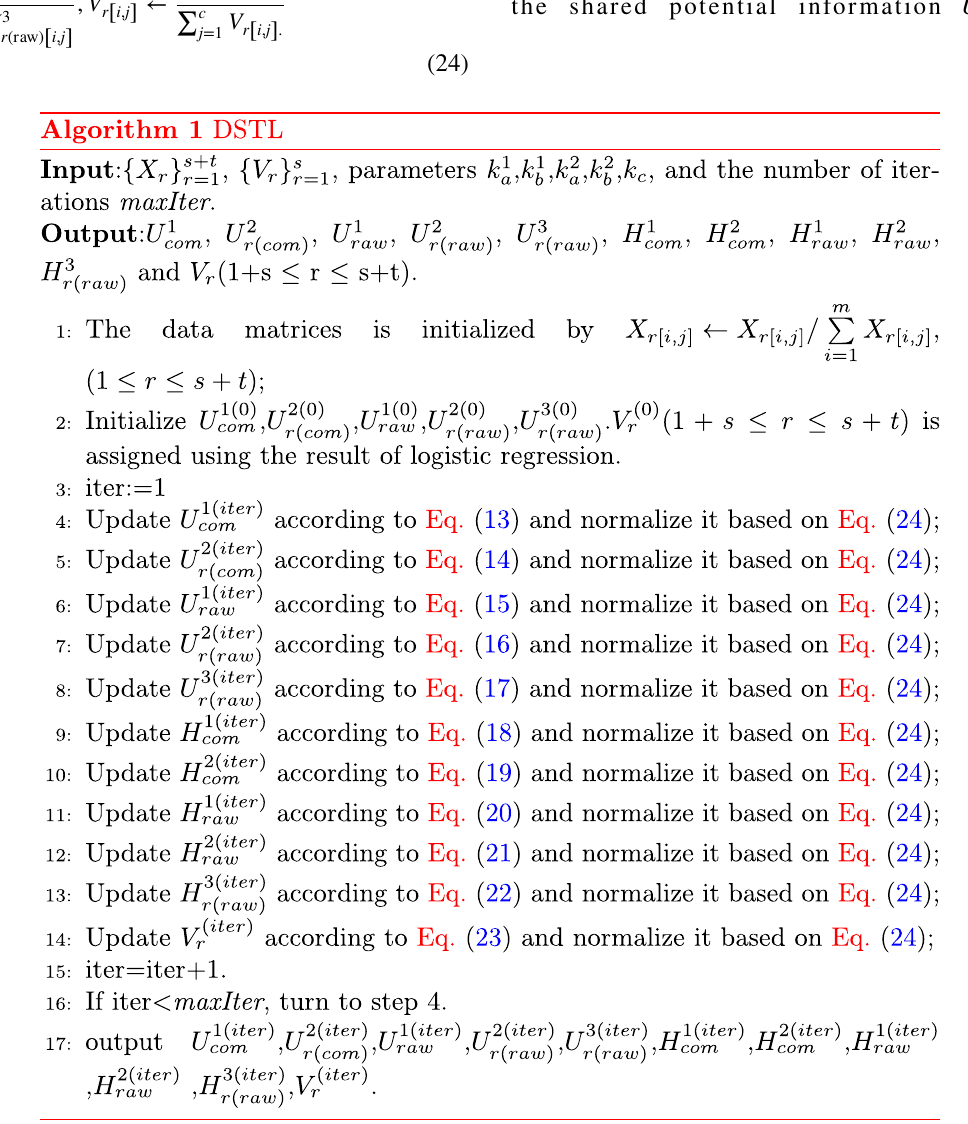
rithm 1 to solve the optimization problem. The inputs of Algorithm 1 include the data matrix of the source and target s + t domains ( { X r } r = 1 ), the label matrix of the source domain s k 1 k 1 ( { V r } a , b , r = 1 ), the number of learned high-level concepts ( k k 2 k 2 c ), and the number of iterations of the algorithm a , b , ( maxIter ). The outputs of Algorithm 1 include U , H and V , where U includes the learned result of the concept extension 3 of the two feature spaces ( U 1 com , U 2 r (com) , U 1 raw , U 2 r (raw) , U r (raw) ), H includes the learned result of the concept intension in the 3 V is the two spaces ( H 1 com , H 2 com , H 1 raw , H 2 raw , H r (raw) ), and result of our classifier classification ( V r (1+s ≤ r ≤ s+t)). In step 2 of Algorithm 1, U 1 com , U 2 r (com) , U 1 raw and U 2 r (raw) are ini- tialized by conducting PLSA [31]. First, we extract the com- mon feature of the source domain and the target domain and run PLSA in the constructed common feature space to obtain m × k 1 a the shared potential information U 1 com ∈ R